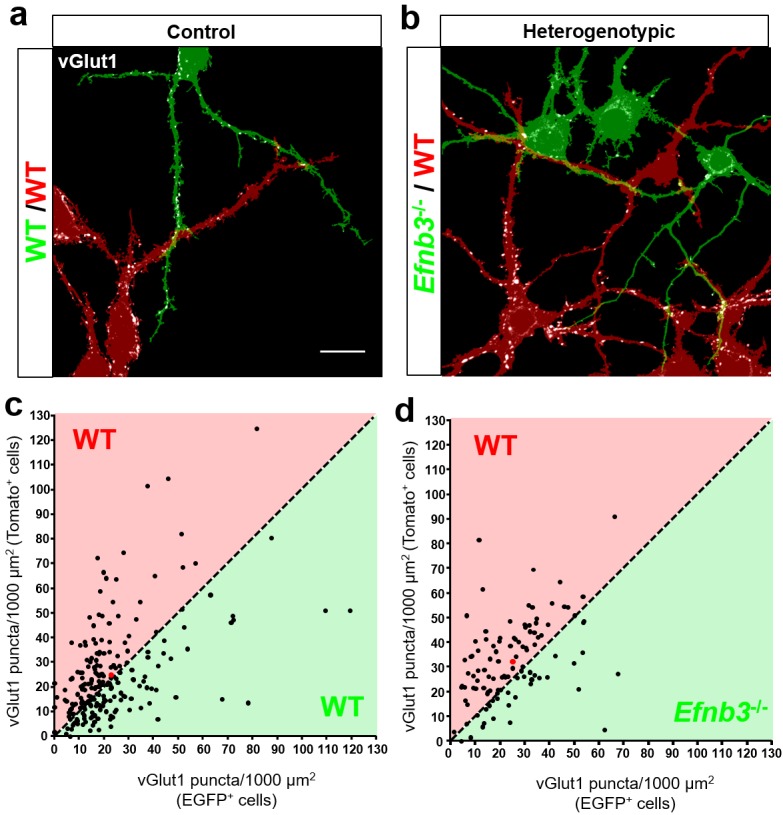
Ephrin-B3 regulates local cell-cell differences in synapse density in MADM cultures.(a and b) Representative image fields and corresponding masks used for analysis from control (a) and heterogenotypic (b) DIV11 MADM cultures. Scale bar, 20 μm. (c and d) Scatter plots in which each point represents the density of vGlut1+ synapses contacting tdTomato+ (y axis) and EGFP+ (x axis) neurons in a single image field. The red point in each graph represents the average of all data points. The proportion of fields in which tdTomato+ neurons received a higher fraction of local synaptic contacts than EGFP+ neurons is significantly higher in heterogenotypic cultures than control cultures (control, n= 218 fields; heterogenotypic, n=108 fields; p=0.0216, Fisher’s exact test).10.7554/eLife.41563.027Figure 8—source data 1.Ephrin-B3 regulates local cell-cell differences in synapse density in MADM cultures.